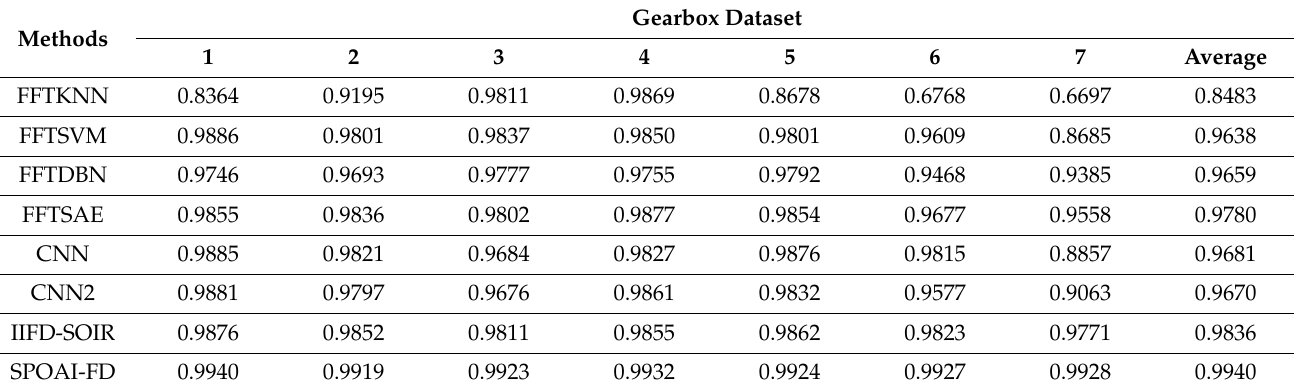
Table 3. Analytical results of Each Fault Class of different methods on gearbox dataset Methods